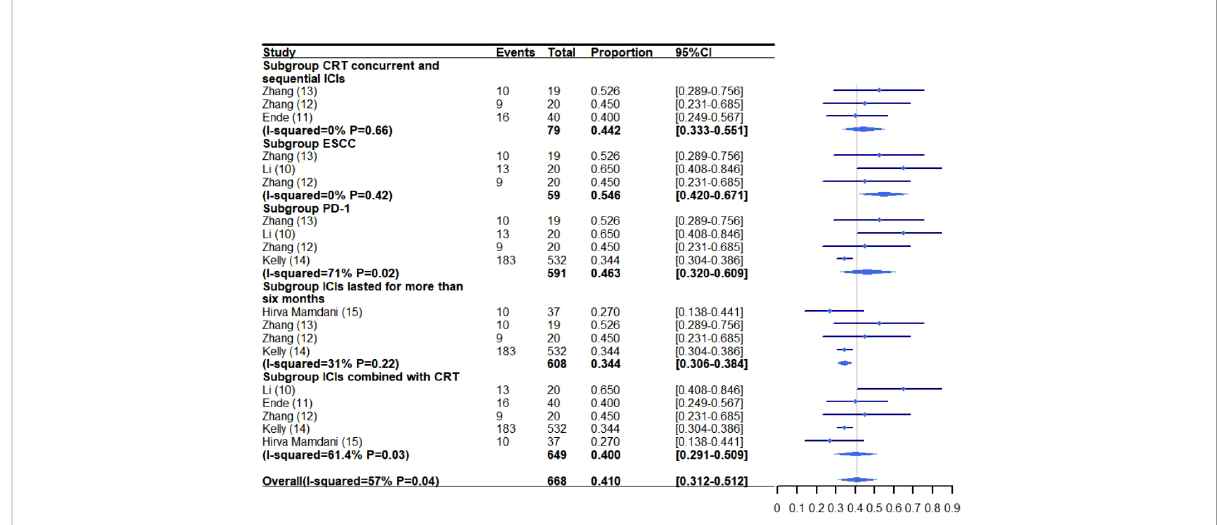
FIGURE 3 Grade 3-5 adverse reaction meta-analysis and forest plot for esophageal cancer patients treated with CRT/RT and ICIs. CRT, Chemoradiotherapy; RT, Radiotherapy; ICIs, Immune checkpoint inhibitors; ESCC, Esophageal squamous cell carcinoma; PD-1, Programmed